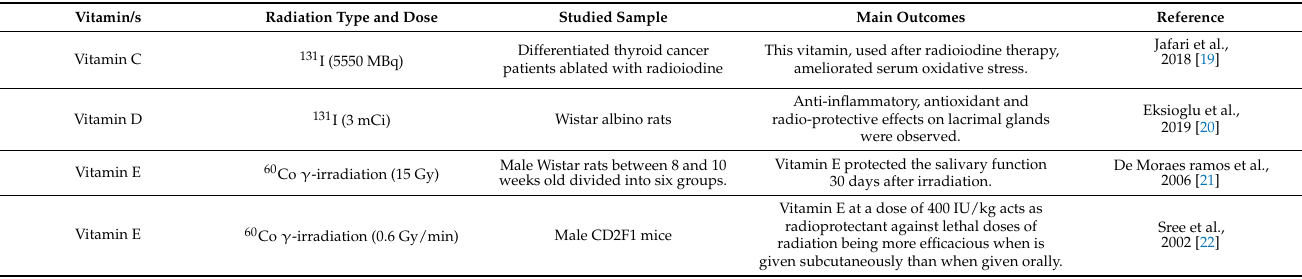
Table 3. In vivo studies about radioprotective effect of